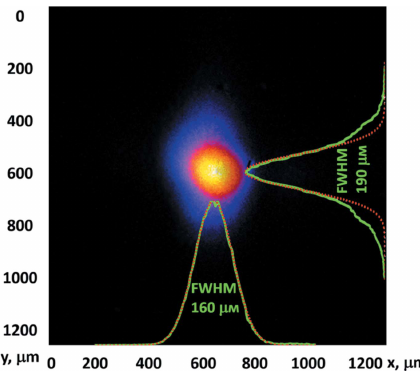
Figure 2 Image of the XFEL beam directly focused by the CRL1 lens measured by means of a LiF detector at IC1. The green profiles correspond to experiment; red profiles are Gaussian